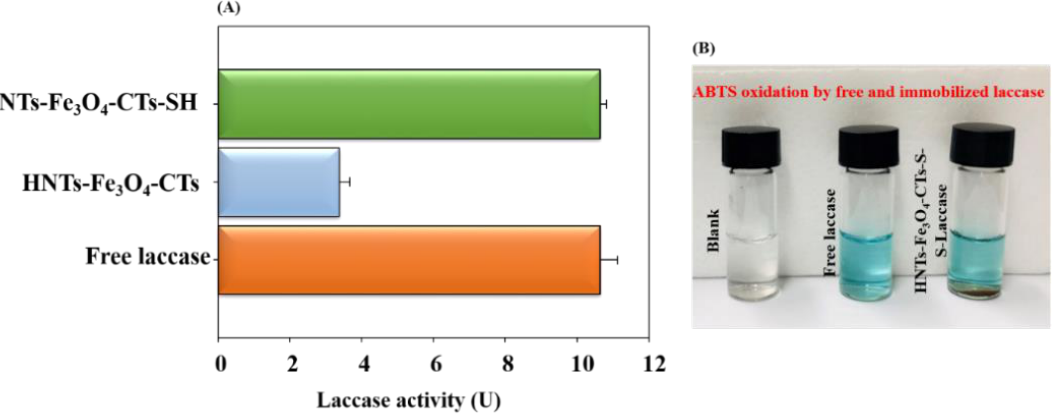
Figure 5. ( A ) Unit activity of free laccase (0.1 mL from 1.5 mg / mL laccase solution in sodium acetate bu ff er (100 mM, pH 4)), laccase immobilized on HNTs-Fe 3 O 4 -CTs (0.1 mL solution containing 1 mg of laccase immobilized HNTs-Fe 3 O 4 -CTs in sodium acetate bu ff er (100 mM, pH 4)), and HNTs-Fe 3 O 4 -CTs-S-S-Laccase (0.1 mL solution containing 1 mg of HNTs-Fe 3 O 4 -CTs-S-S-Laccase in sodium acetate bu ff er (100 mM, pH 4)). ( B ) Photographic image representing the color change after the oxidation of ABTS by free laccase and HNTs-Fe 3 O 4 -CTs-S-S-Laccase.